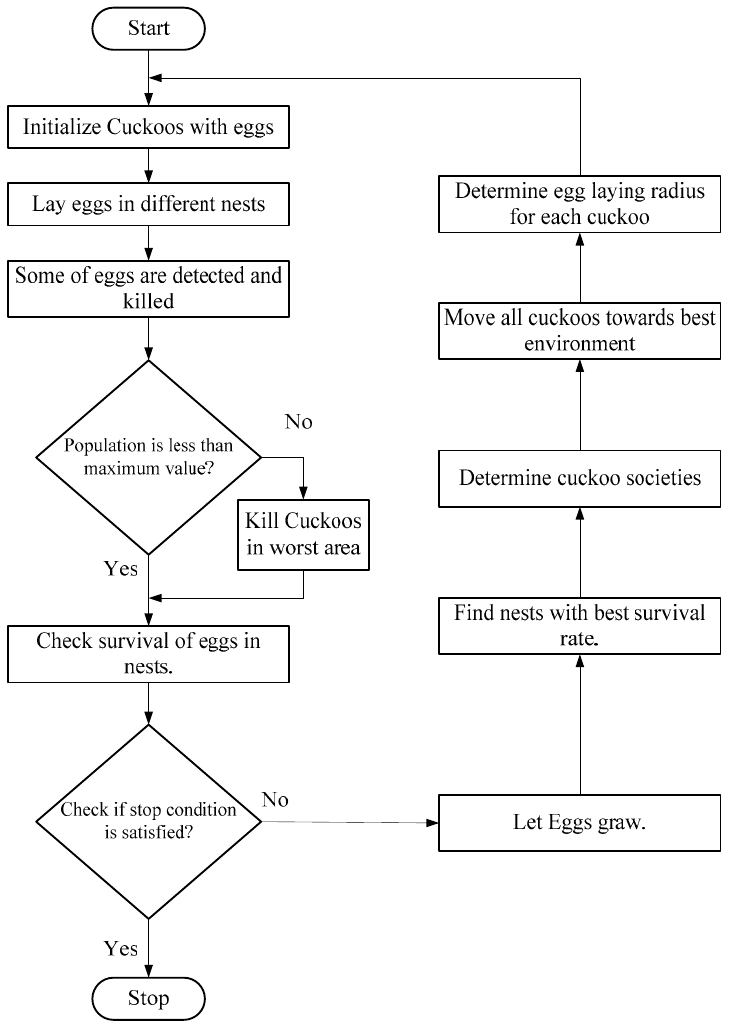
Figure 7. Flowchart for the Cuckoo Optimization Algorithm.